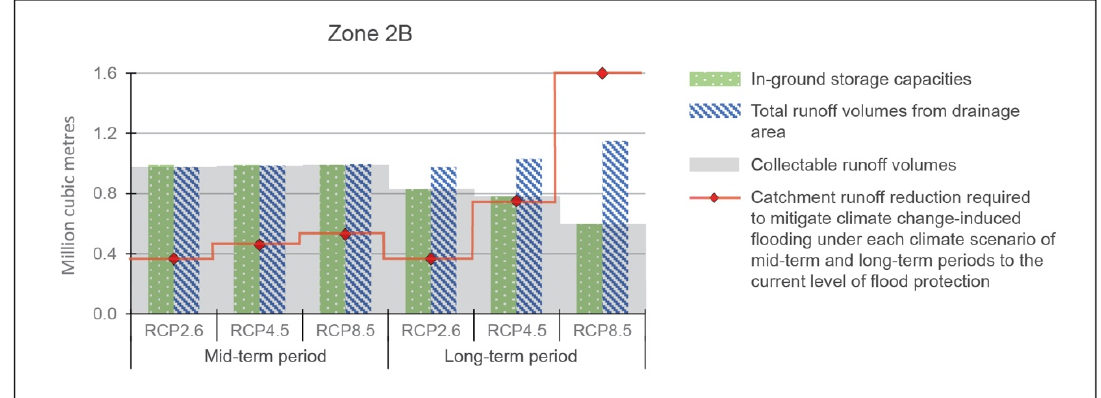
Figure 7. Collectable runoff volumes of Zone 2B (shaded in grey) are almost equivalent to the total runoff volume from the zone’s drainage area (blue bar) over the mid-term. However, runoff volumes would exceed the storage capacity (green bar) in the long term under all climate scenarios. Collectable runoff volumes are higher than the runoff reduction required to mitigate the increased flooding with climate change (red line), except under RCP8.5 in the long term. Under this scenario, the increased catchment runoff volume is three times greater than the amount the zone can collect.